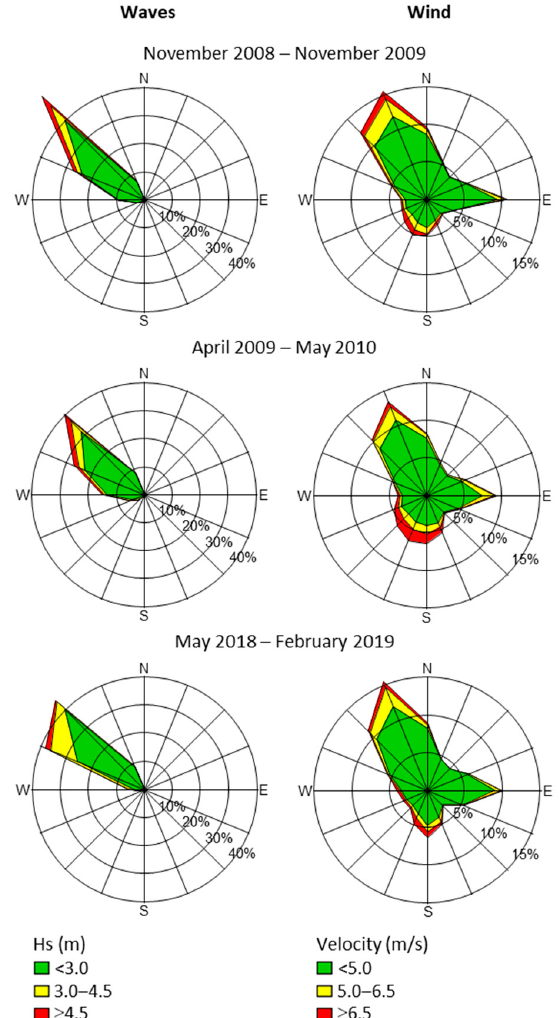
Figure 4. Distribution of 3-hourly wave directions for three significant-wave-height classes ( left plots ) and of hourly wind directions for three velocity classes ( right plots ) for the three yearly periods.